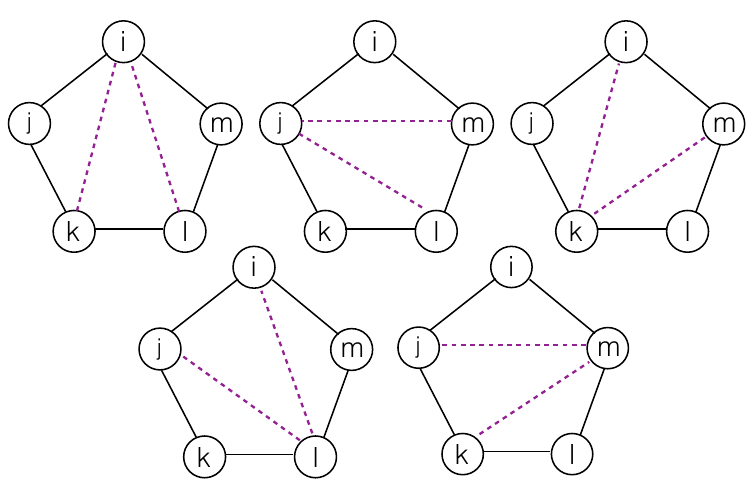
Figure 3 . The (cid:12)ve di(cid:11)erent ways of cutting the inside of a decagon. The outside part can be cut similarly in (cid:12)ve di(cid:11)erent ways. If the solid lines have bridge length greater or equal to two, at one- and two-loops only the one-particle and two-particle contributions of (cid:12)gure 2 have to be taken into account for its computation. The result of the computation has to be the same for all the cuts, i.e. the result is rotation invariant, for example, by doing i